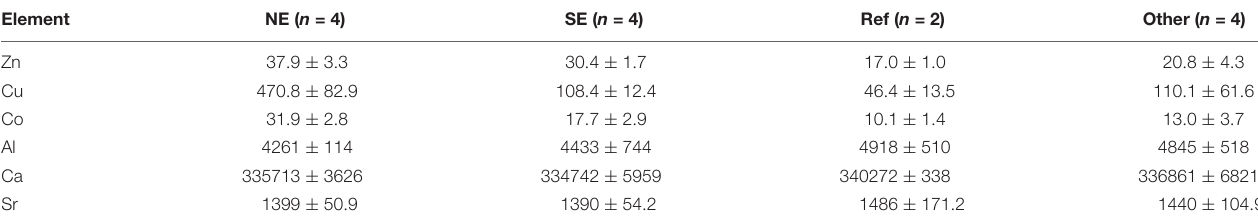
Concentrations in